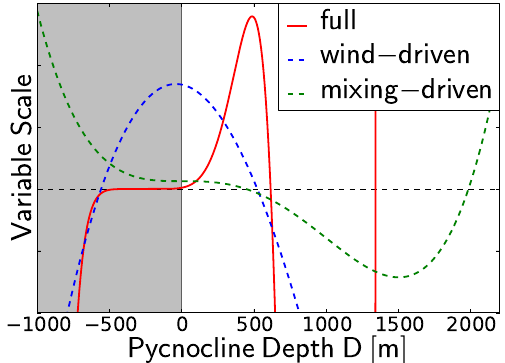
Figure 2. Trend of the governing equation for the full case (red line), the wind-driven case ( m U = 0, blue line) and the mixing- driven case ( m W = m E = 0, green line). The intersections with zero (black dashed line) are solutions of the polynomial but those in the grey shadowed area correspond to a negative pycnocline depth. Therefore they are not physical. All three cases have two posi- tive solutions, a lower stable, physical one D and a higher un- stable or non-physical one ˆ D . In the wind-driven case the non- physical solution is out of range of the pycnocline but this solution is shown in Fig. 5. For the full case the solutions are D = 616m and ˆ D = 1342m, for the wind-driven case they are D = 523m and ˆ D = 6190m and for the mixing-driven case they are D = 446m and ˆ D =